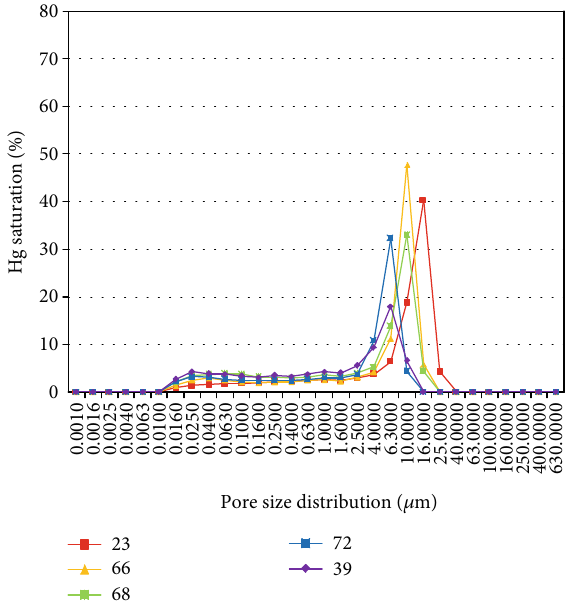
Figure 11: Pore size distribution from the HPMI experiment.